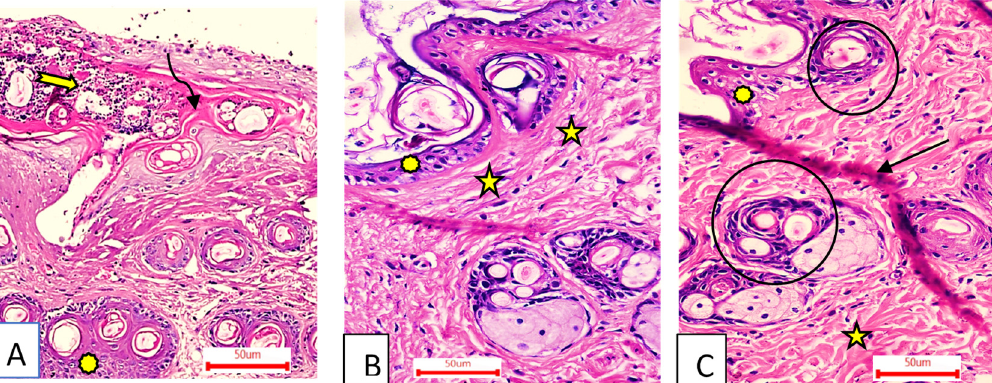
Figure 8. Group I ( A ) had a wide wound area (curved arrow), heavy inflammatory cellular infiltration in an acidophilic matrix (tailed arrow), and normal skin (asterisk). Group II ( B ) had an epidermis formed of 1–3 rows of epithelial cells (asterisk) and collagen fibers compactly arranged with prominent fibroblasts (stars). Group III ( C ) had typical epithelium, thin scar tissue extending into the dermis (black arrow), and reticular dermis with coarse, wavy collagen bundles arranged in different directions (star). Newly formed hair follicles (circles) (H&E stain ×200).